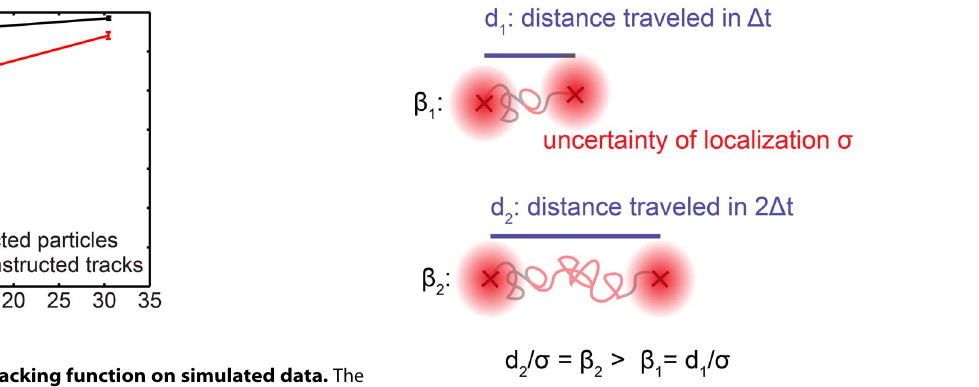
Figure 3. Illustration of the parameter b . Depending on the SNR, a particle can be localized within a certain localization precision s ( red circle ). After a certain time interval the particle has traveled a distance d . If s is a substantial fraction of the distance d (i.e. b is small), the measurement of d is imprecise, leading to errors in the determination of the diffusion coefficient. Increasing the time interval D t and thus b allows a more precise measurement of d .